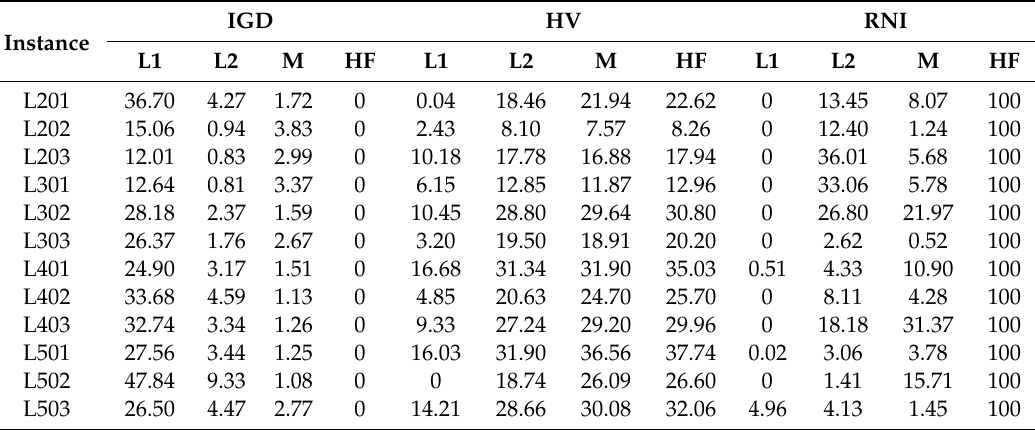
Table 8. Mean IGD, HV, and RNI values of each fleet composition.